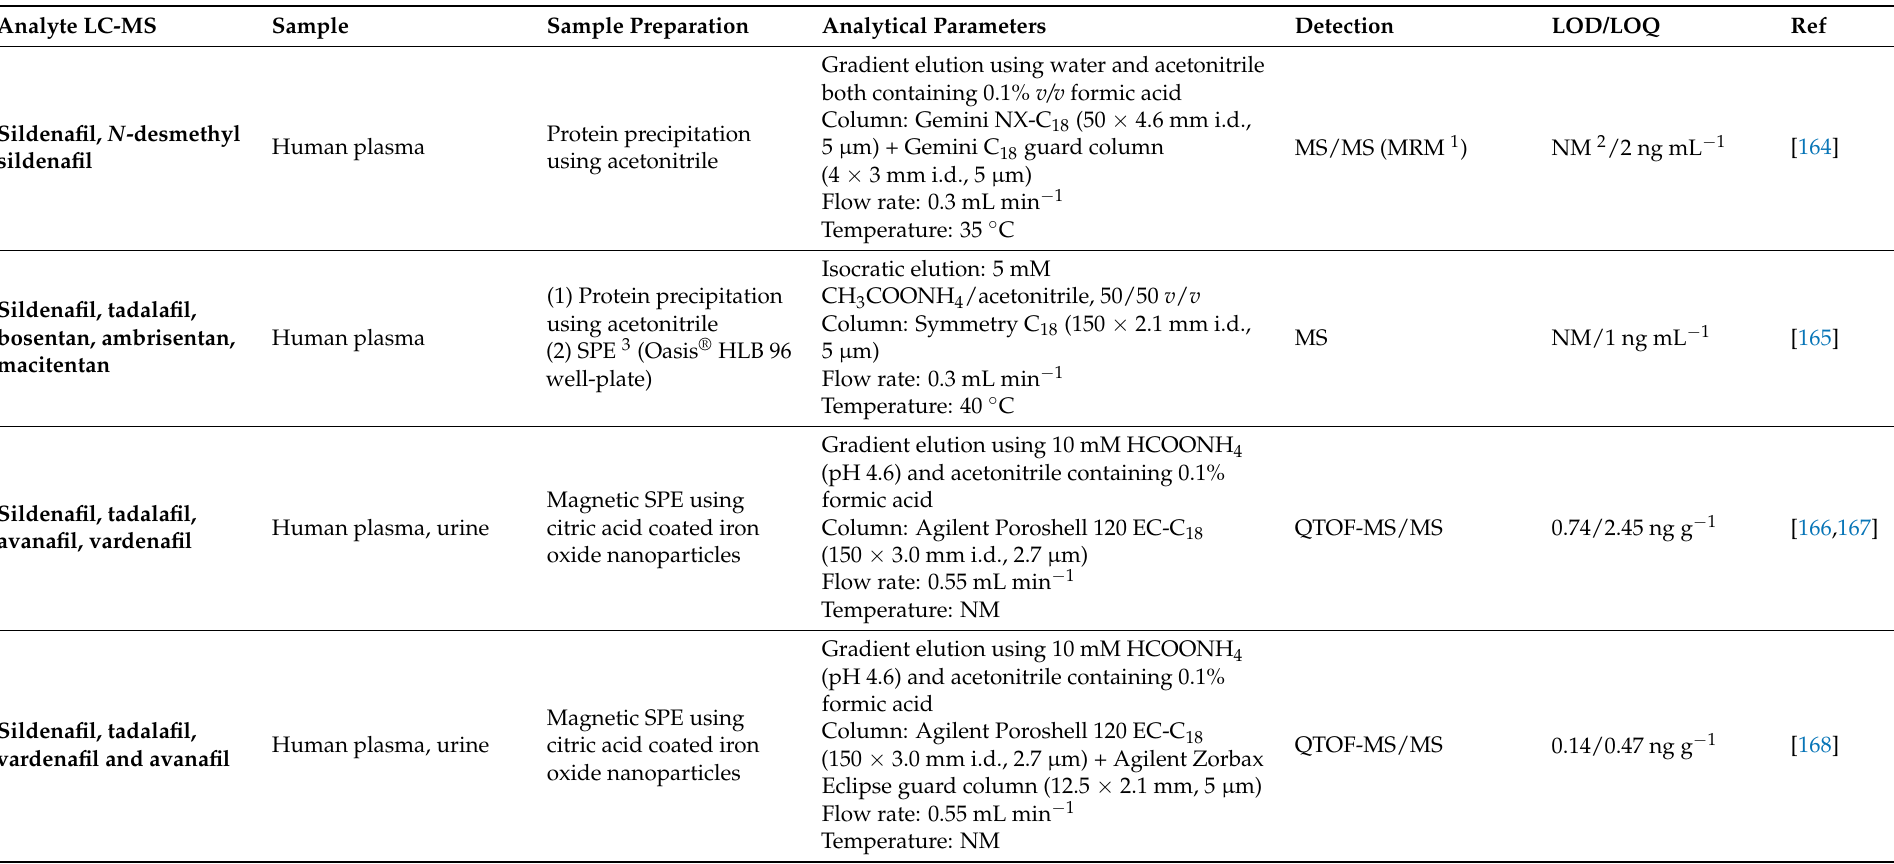
Table 5. Overview of recent bioanalytical methods of